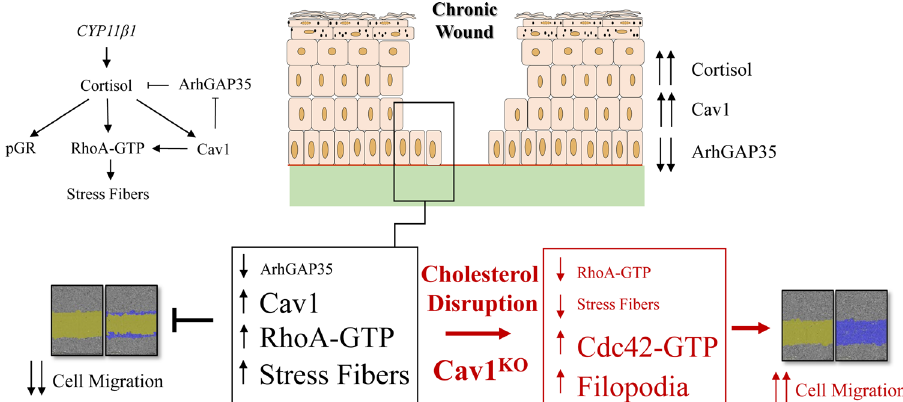
Fig. 6 Proposed mechanism of action. Increased cortisol synthesis in DFUs which binds to and activates glucocorticoid receptor leads to increased levels of active cortisol, which subsequently leads to downregulation of GR repressor ArhGAP35 as well as an upregulation of Cav1. Downregulation of ArhGAP35 stimulates activation of RhoA and induction of stress fi bers to inhibit directional keratinocyte migration and wound closure. Perturbation of caveolae (by M β CD) or knockout of Cav1, reverses corticosteroid-mediated induction of stress fi bers and inhibition of directional cell migration and may be used as a potential therapeutic target to promote wound re-epithelialization of non-healing